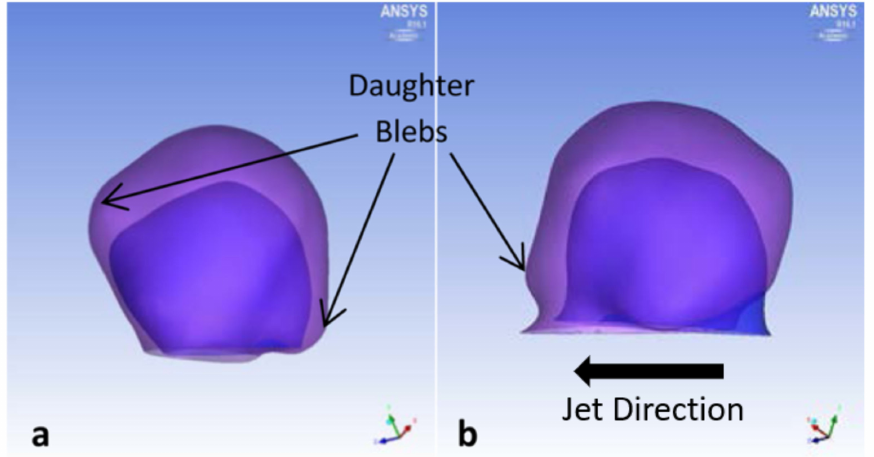
Figure 4. P2 aneurysm growth comparisons between initial diagnosis and follow-up times. ( a ) Side view plane normal to impingement jet, and ( b ) side view plane parallel to impingement jet. Block arrow indicates direction of impingement